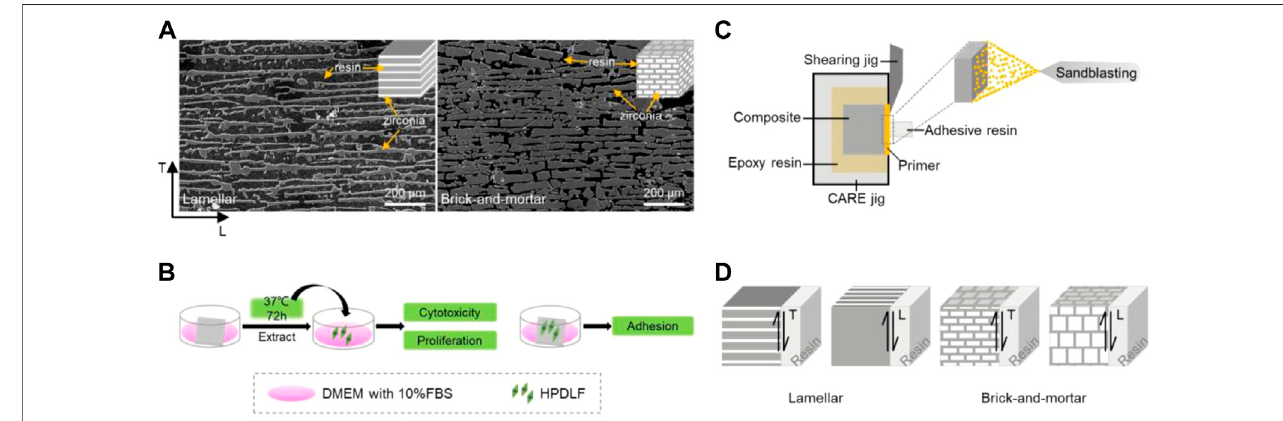
FIGURE 1 | Flow diagram of this study. (A) Typical SEM images of the two composites; (B) simple fl ow charts for cell experiments; (C) model diagram of shear bondingstrengthtest; (D) modeldiagramofexperimentalmaterialsandsheardirection(SEMimage:darkblackisresin,brightwhiteiszirconia;modeldiagram:darkgray is resin, white is